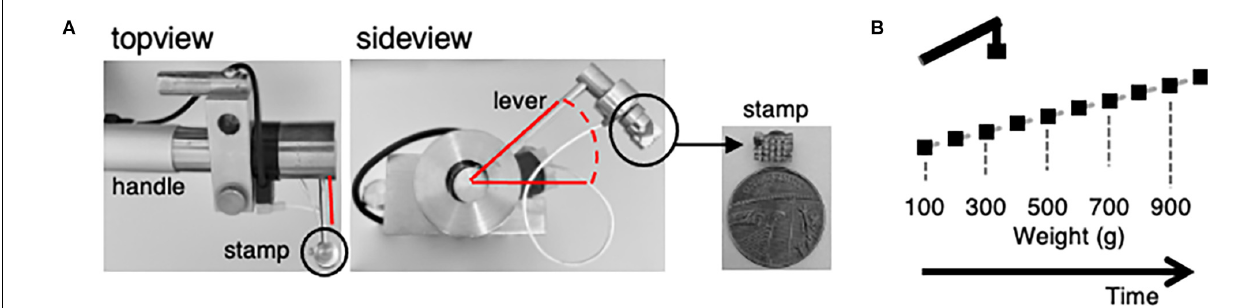
FIGURE 2 | A custom-made electronically controlled mechanical stimulator and the mechanical stimulation protocol for in vivo calcium imaging. (A) Photos of the electronically controlled mechanical stimulator and its stamp. Top view showing the lever attached to the handle, sideview giving insight into the rotation angle of the lever highlighted in red and the stamp attachment (black circle). Enlarged picture of the stamp in comparison to a one penny coin. (B) Illustration of the mechanical stimulation protocol. Weight was increased from 100 g (0.09 N) to 1,000 g (0.9 N) in 100 g increments every 60 s. Stimulus duration was about 1